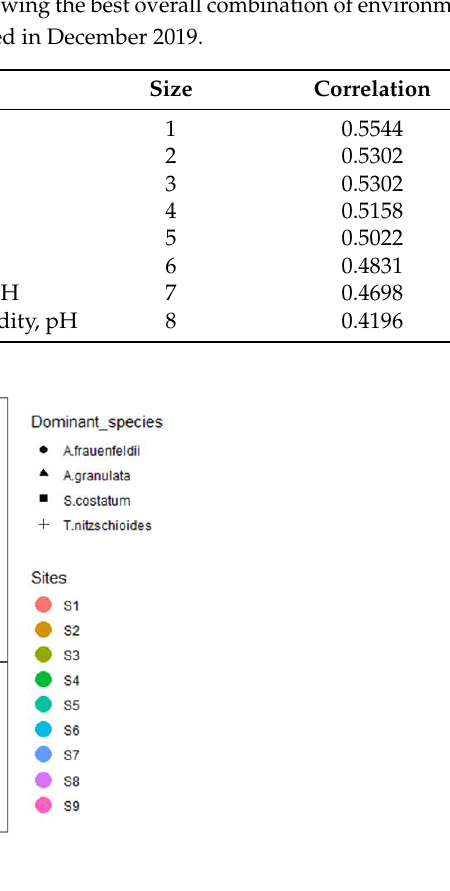
Figure 6. CCA of the relationship between environmental parameters and phytoplankton species abundance in the waters around Macau examined in December